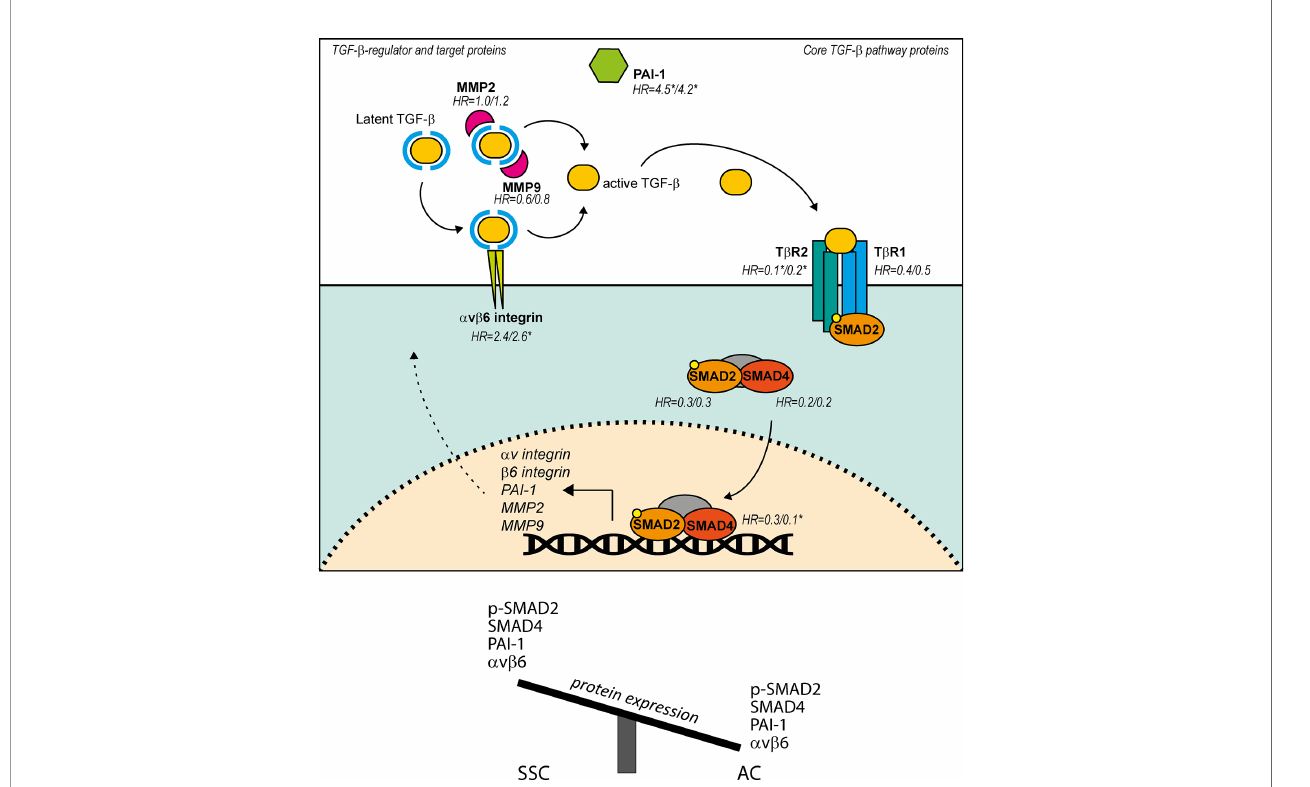
FIGURE 6 | Summary of the presented fi ndings of TGF- b pathway, TGF- b regulator and TGF- b target proteins in AC, and differences in expression between AC and SCC in regard to these proteins. TGF- b pathway starts with binding of TGF- b to T b R2, leading to phosphorylation of T b R1 and subsequent phosphorylation of SMAD2. SMAD2 together with SMAD4 and SMAD3 (not indicated) form a complex and translocate to the nucleus to regulate transcription of TGF- b target genes PAI-1 , a v integrin , b 6 integrin , MMP2 and MMP9 . Av b 6 integrin and MMP2/9 mediate cleavage of latent TGF- b . Hazard ratios (HR) are calculated low over high, and are shown for the proteins investigated in the present study. HRs are shown as RFS/DSS, signi fi cance (p ≤ 0.05) is indicated